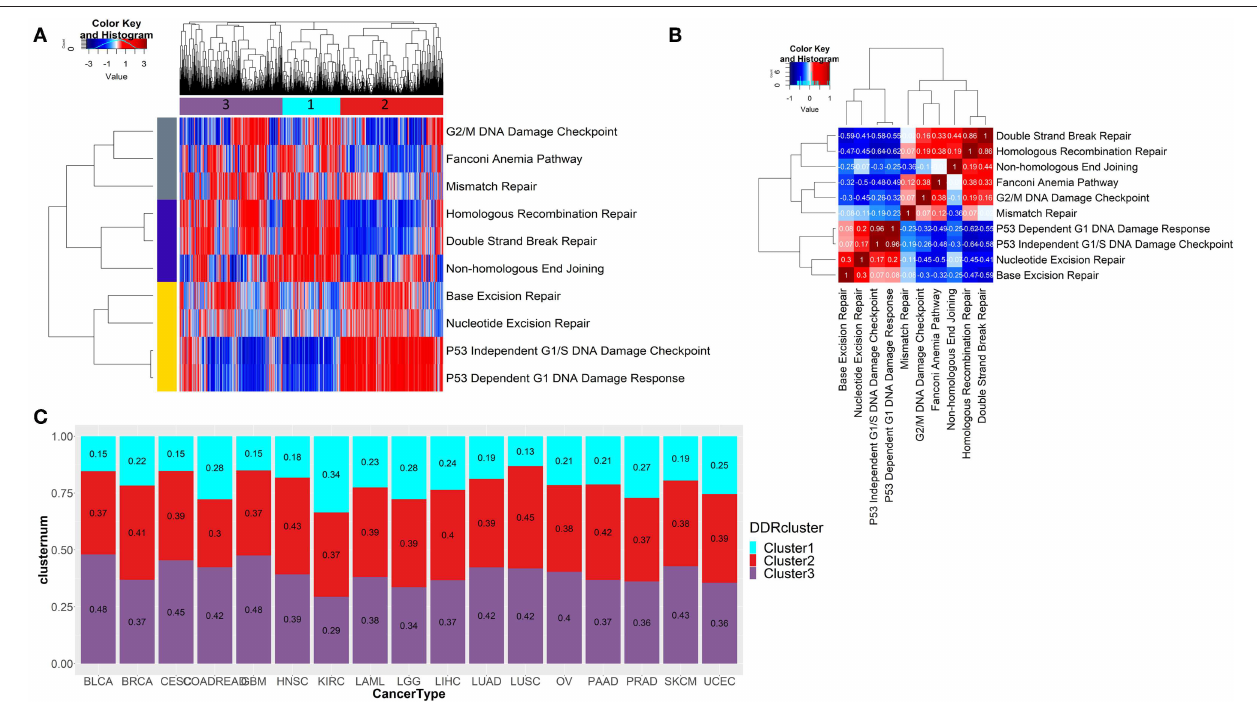
FIGURE 2 | (A) Unsupervised clustering of ssGSEA scores of 10 DDR pathways across 7,272 tumor samples reveals three distinct clusters of tumors. A mutually exclusive enrichment pattern can be seen between these DDR pathways: P53 dependent or independent G1 DNA damage response and double strand break repair, homologous recombination repair, and non-homologous end joining. (B) Correlation plot showing the correlation of ssGSEA enrichments of 10 DDR pathways. (C) Stacked barplot shows the fraction of samples belonging to each of the three DDR clusters identified from (A) in each of the 17 tumor types from